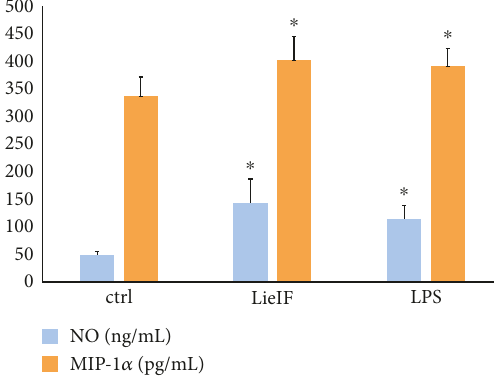
Figure 5: E ff ect of recombinant LieIF protein on nitric oxide (ng/mL) and MIP-1 α (pg/mL) production by J774A.1 macrophages. Macrophages were stimulated with recombinant LieIF (10 μ g/mL) and LPS (1 μ g/mL). Unstimulated cells were used as the negative control. After 24 h, the cell supernatants were collected and NO and MIP-1 α secretion were measured by Griess reaction and ELISA, respectively. The results are presented as the mean ± SD and data shown are representative of three independent experiments. ∗ indicates statistically signi fi cant di ff erences as compared to the negative